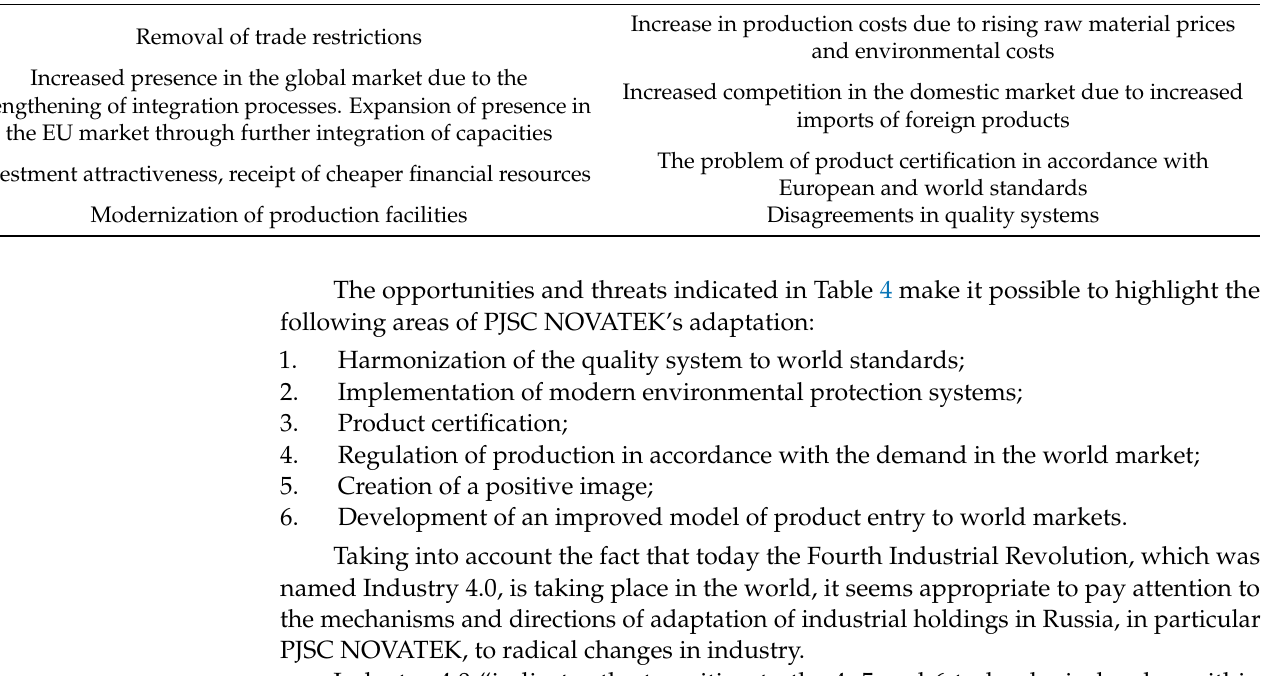
Table 4. Positive and negative aspects of the impact of integration on the international markets of PJSC NOVATEK. Positive Consequences Negative Consequences Removal of trade